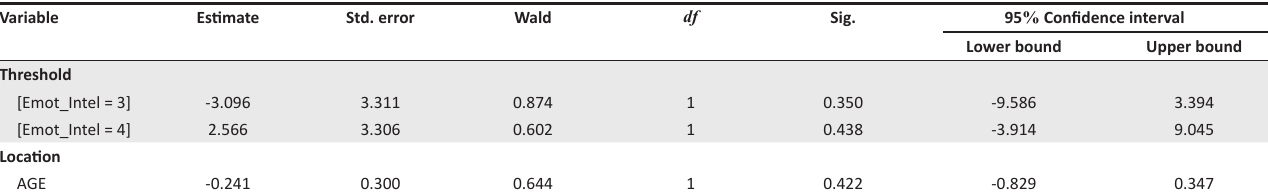
TABLE 6: Parameter estimates. Variable Estimate Std.